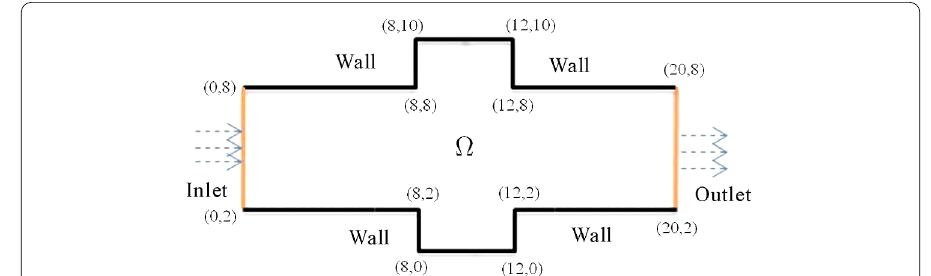
Figure 1 The computational domain and the initial boundary values.